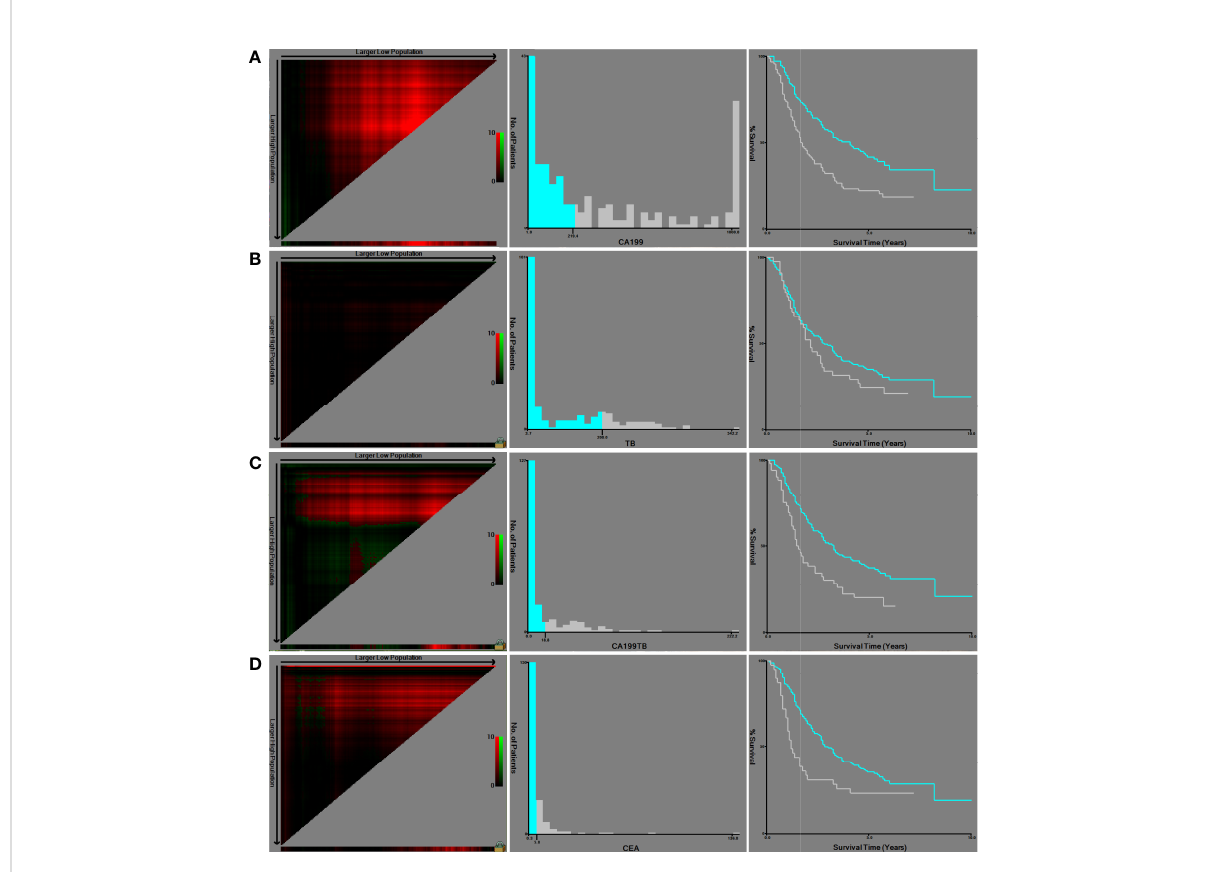
FIGURE 1 X-tile software was used to obtain the cut-off values of continuous variables and to perform survival analysis: (A) CA19-9; (B) TB; (C) CA19-9/ TB; (D)